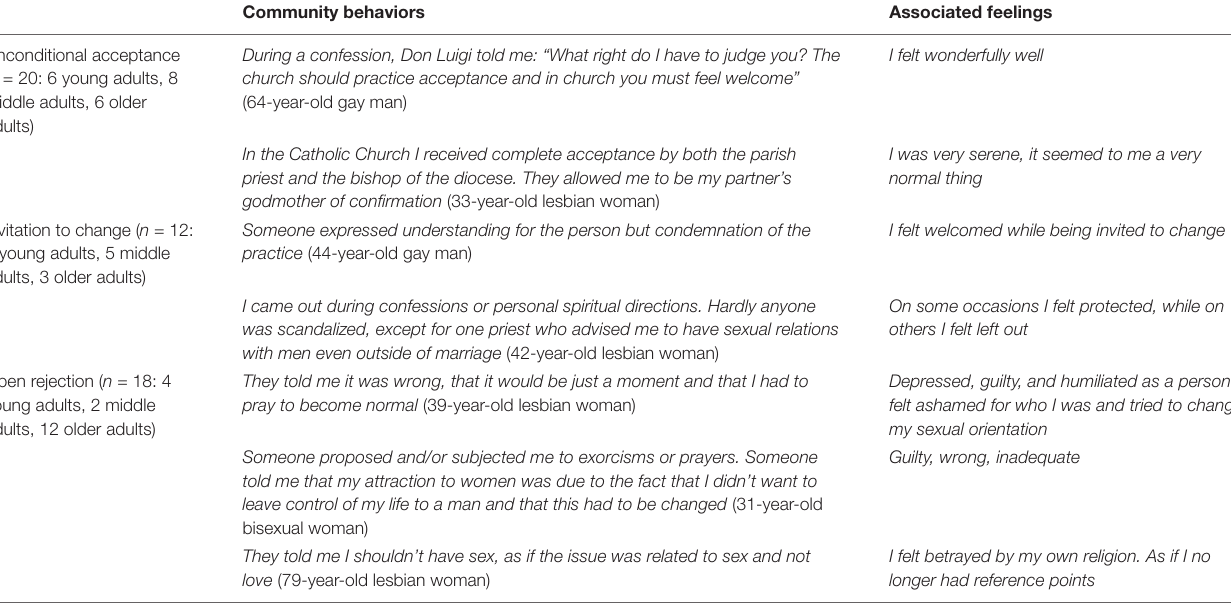
TABLE 5 | Catholic community reactions to CO: Thematic categories and representative quotations ( n = 50).